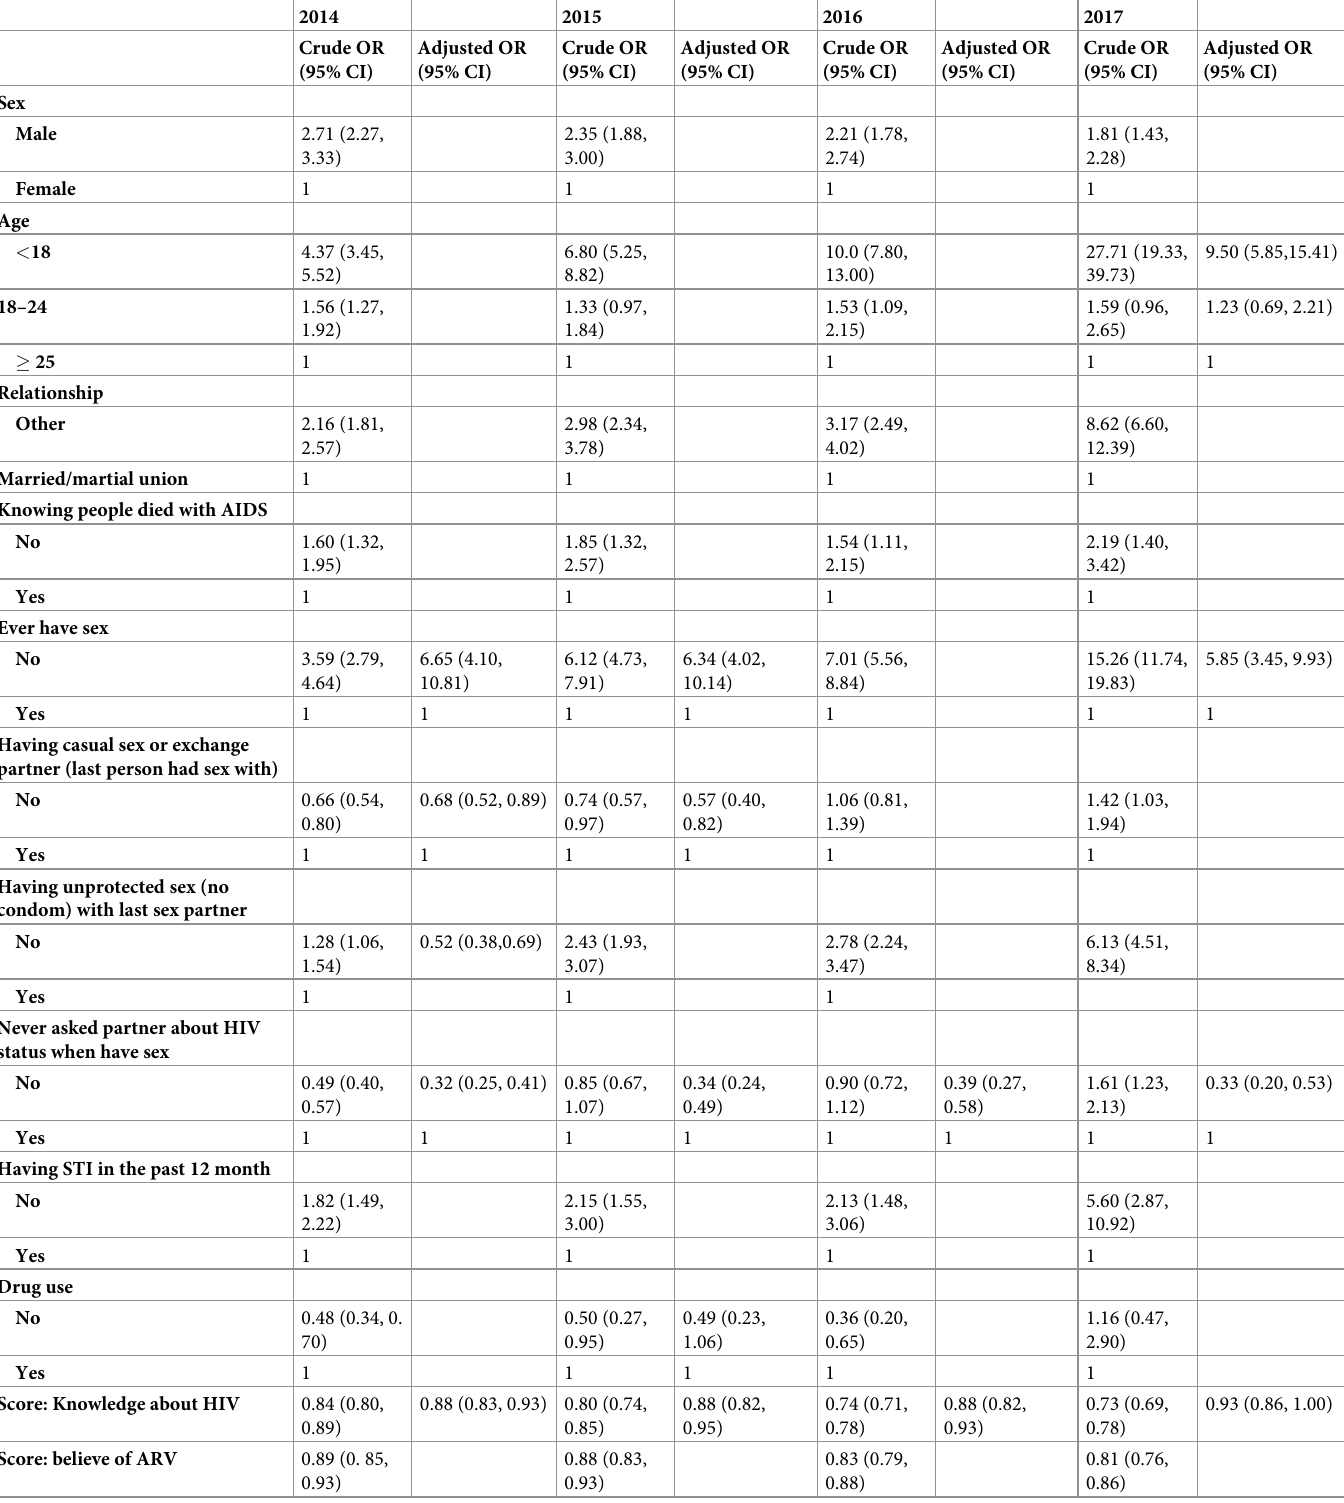
Table 2. Demographic and behavioral factors associated with never tested for HIV